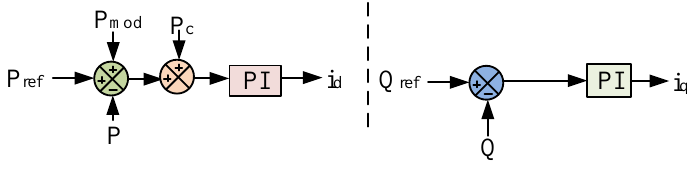
Figure 9. PQ controller for